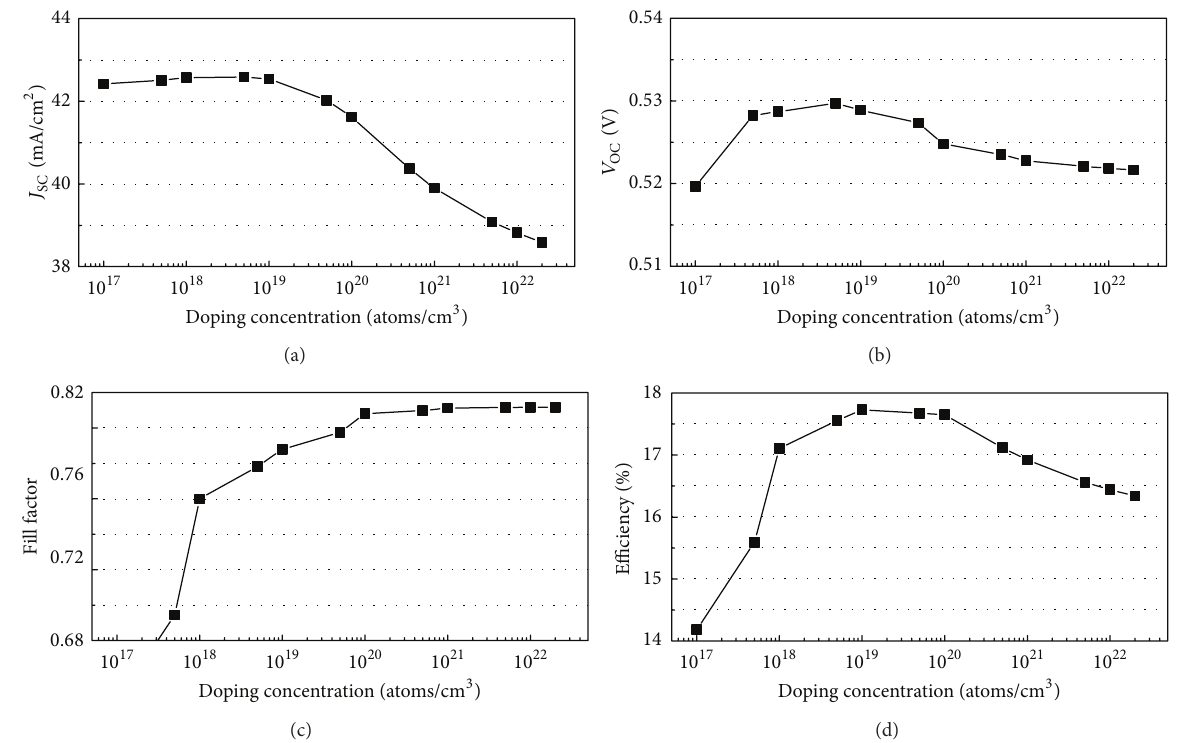
Figure 6: Dependence of the output parameters: (a) short circuit current density, (b) open circuit voltage, (c) fill factor, and (d) efficiency of the cell, on the boron concentration, including the effects of the contact resistance.